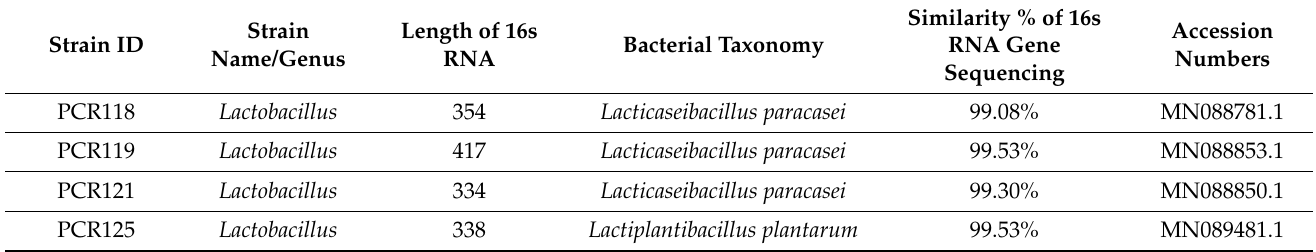
Table 4. Provisionally Taxonomy of Bacterial Isolates.